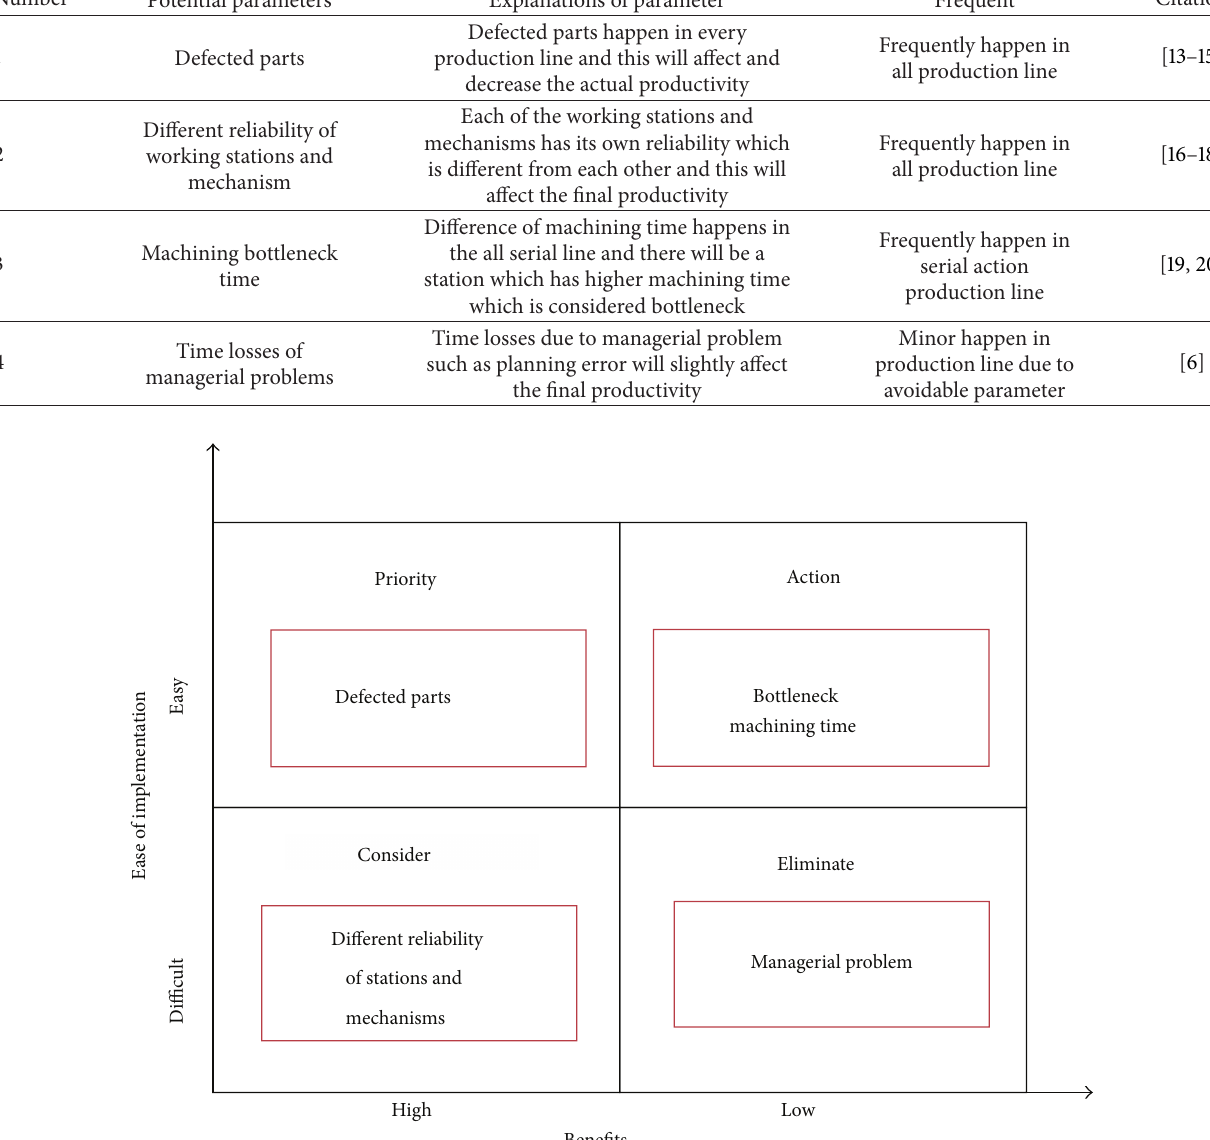
Figure 5: PACE Prioritization Matrix of parameters of mathematical model of